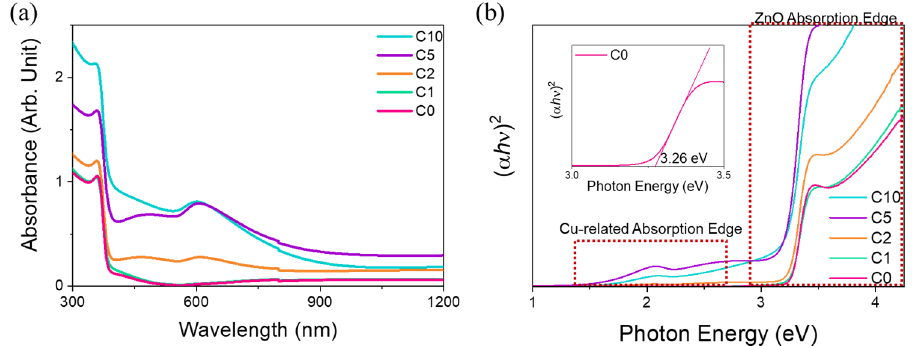
Figure 4. ( a ) UV-vis absorbance spectra and ( b ) Tauc plots of the Cu-ZnO thin films. Each absorption edge is highlighted with red dotted lines. The absorption edge of C0 is plotted separately (inset).